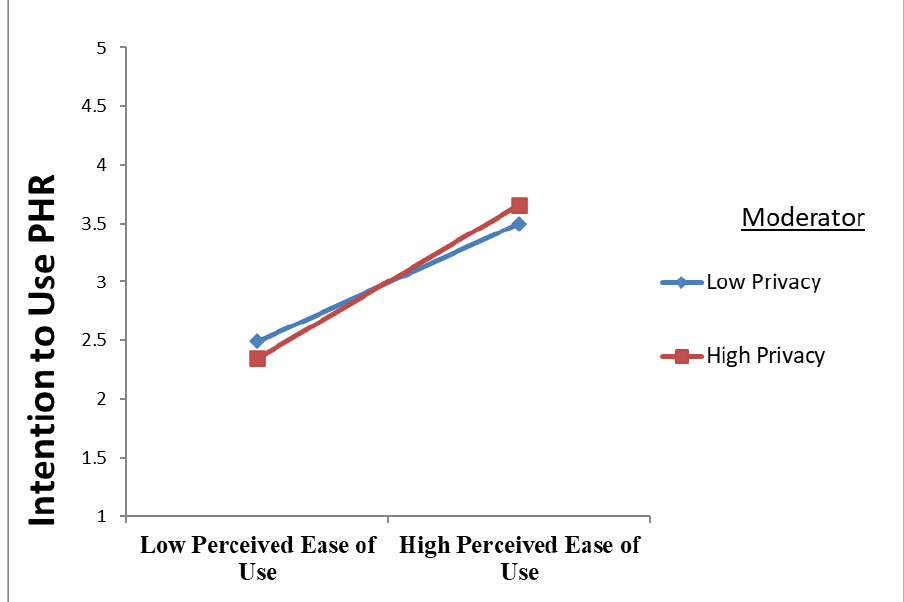
Figure 2. Privacy’s Positive Moderating Role on the Association between Perceived Ease of Use and Intention to Use PHR. Table 6. Two-way Interaction Effects for Unstandardised Variables (PEOU, Privacy, and Intention to Use